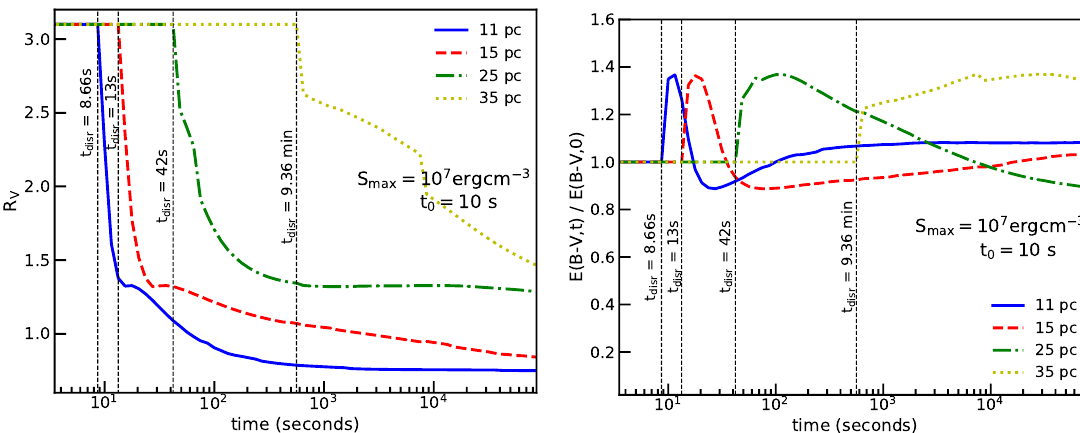
V ) (right panel) and for different cloud distances − V ) begin to change when grain disruption begin at −